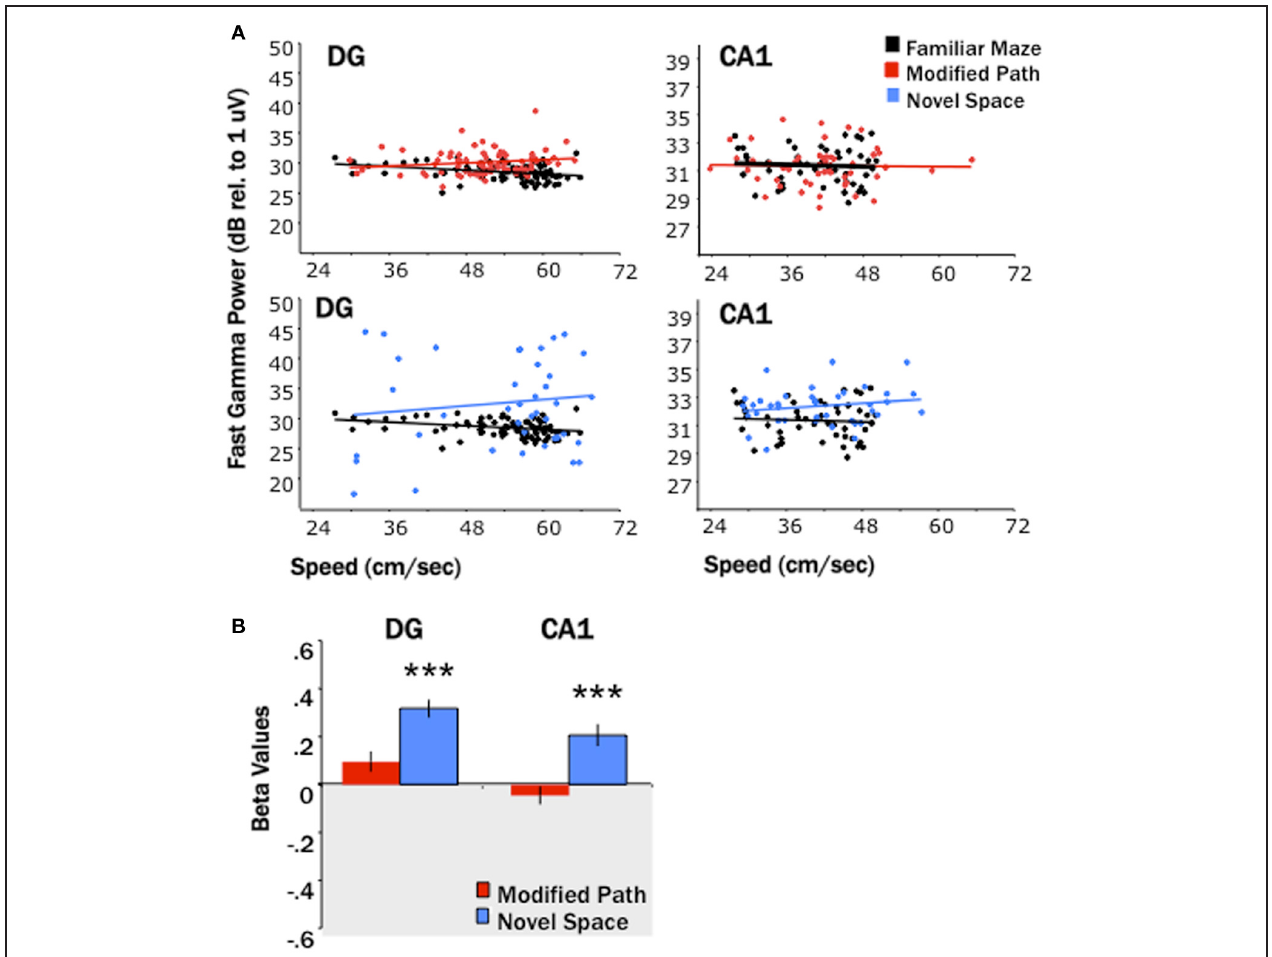
space (blue). Power is presented in dB relative to 1uV. (B) The standardized regression coefficient ( β -values) for fast gamma power comparing changes in the modified path (red) and novel space (blue) from the familiar condition independent of speed ( ∗∗∗ p < 0 .